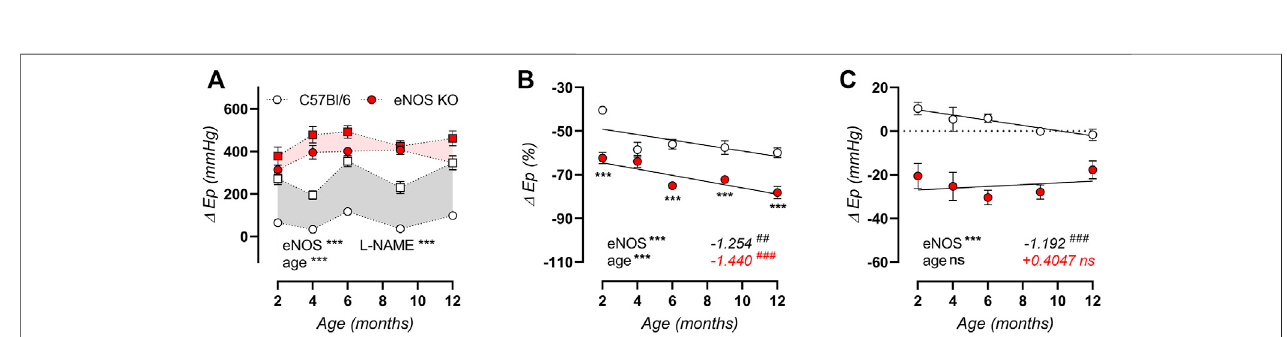
FIGURE3| Activecontraction-dependentaorticstiffeningisnotaffectedbyageineNOSknockoutmice.Thedifferenceinisobaricaorticstiffness(E p )atcalculated 80 – 120 mmHg distending pressure is shown for contraction induced with 2 μ M PE in the absence (circles) and presence (squared) of 300 μ M L -NAME to inhibit basal NO production (A) . Grey and light red shading indicate the amount of contraction-dependent stiffening that is suppressed by basal NO in C57Bl/6 mice and eNOS knockout control mice, respectively. The percentage inhibition of contraction-dependent stiffening at calculated 80 – 120 mmHg distending pressure by 35 µM diltiazem in 2 μ M PE precontracted aortic rings (in the presence of 300 μ M L -NAME) was used to indicate VGCC contribution (B) . The effect on isobaric stiffness at calculated 80 – 120 mmHg distending pressure by removal of all active VSMC tone by 10 µM DEANO compared to baseline Krebs-Ringer conditions was plotted (C) . Age-dependent changes in B and C were analyzed using linear regression (slope displayed, bottom right). An F-test was used to assess if the slope was different from zero. Statisticalanalysisusingthree-wayANOVA (A) or two-way ANOVA (B,C) .Overall signi fi cance(bottom left) andpost-hoc signi fi cance (in graph)are listed.Nopost- hoc signi fi cance is listed in (A) . ANOVA: ns, p > 0.05; **, p < 0.01; ***, p < 0.001. F-test: ns, p > 0.05; ##, p < 0.01; ###, p <